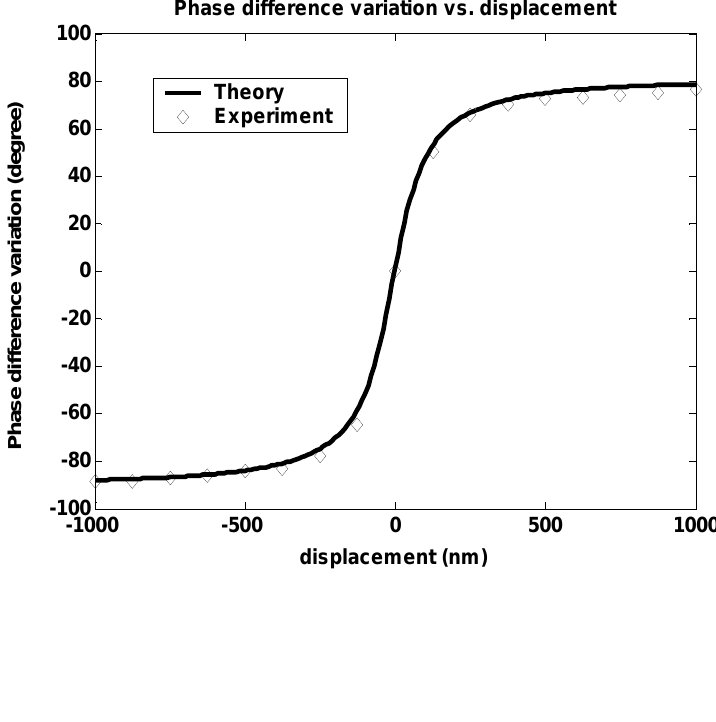
Figure 7. The experimental and theoretical curves of the total phase difference variation versus the displacement Δ z